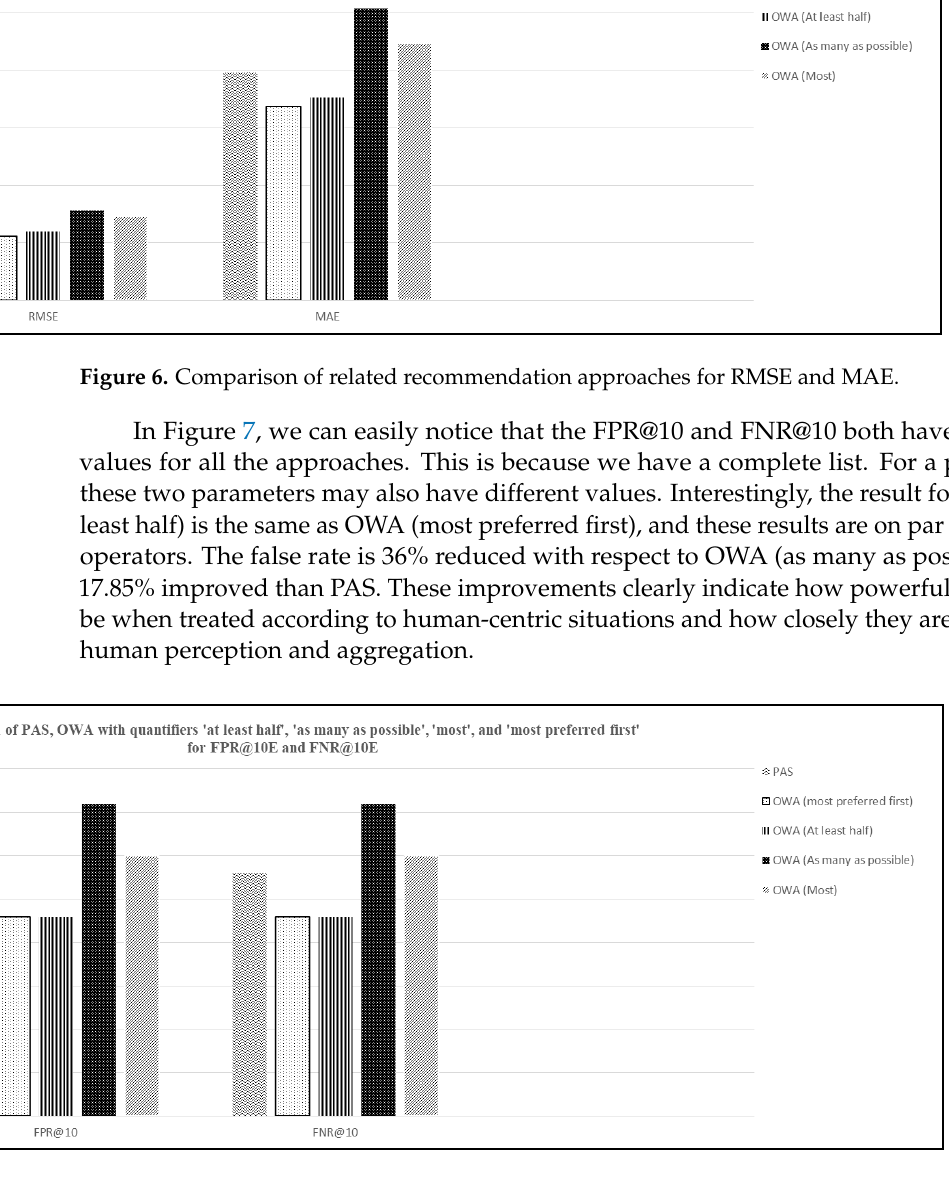
Figure 7. Comparison of related recommendation approaches for FPR@10 and FNR@10.